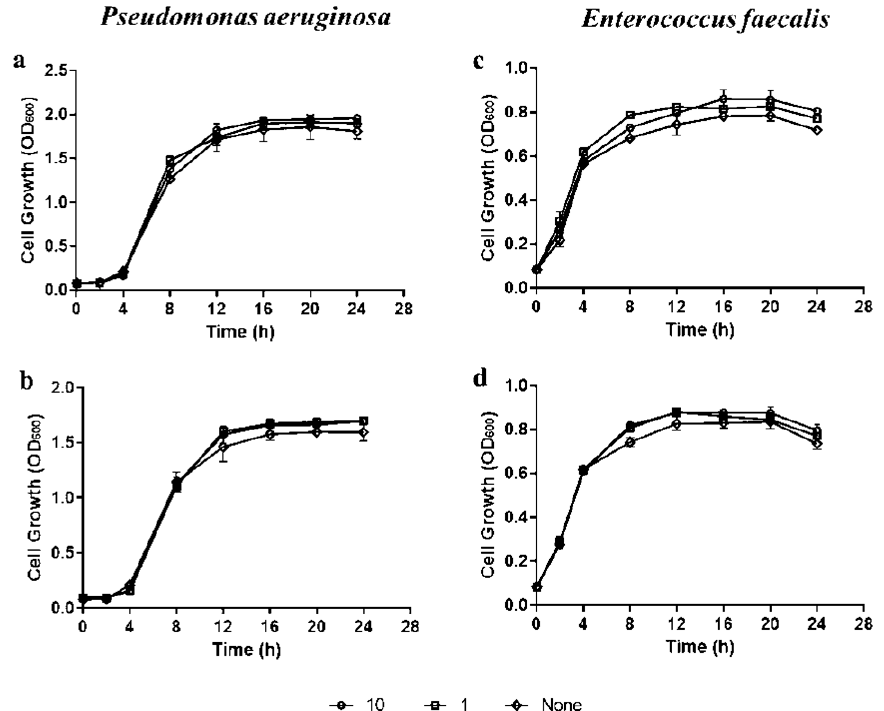
Figure 4. The growth of P. aeruginosa ( a , b ) and E. faecalis ( c , d ) cells in the presence of pepsin ( a , d ) and trypsin ( b , d ) cultured at 37 °C for 24 h with shaking. Bacterial turbidity was measured at OD600 nm using a spectrophotometer at intervals of 2 h over a 24 h incubation period with different concentrations of enzymes in three independent experiments.